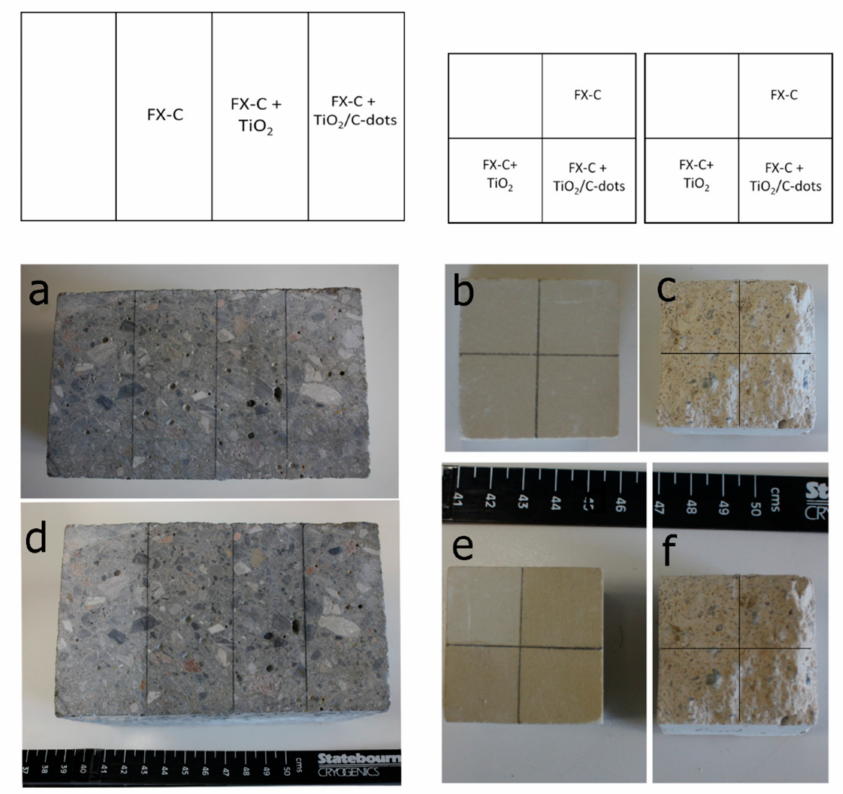
Figure 12. Concrete ( a , d ), limestone ( b , e ) and lime mortar ( c , f ) specimens before application and after application,